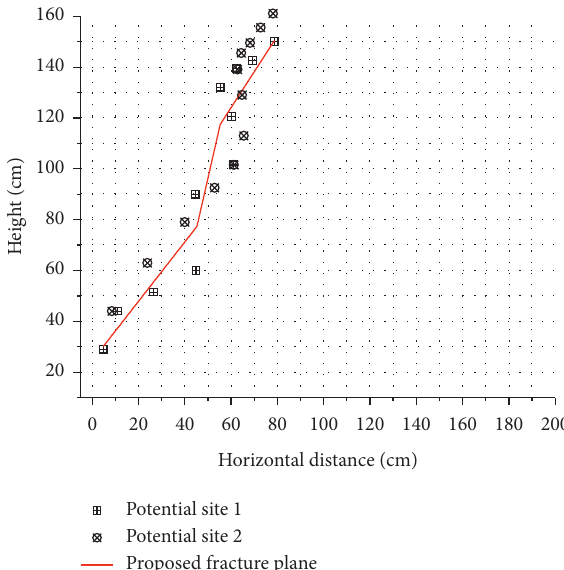
Figure 12: Trilinear potential fracture